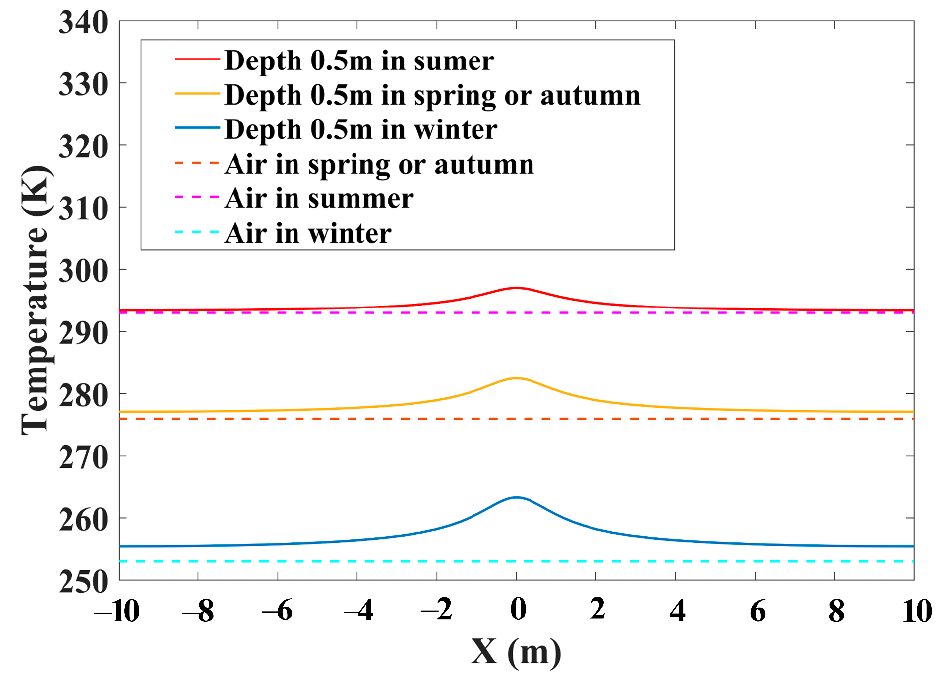
Figure 17. Temperature distribution at 0.5 m depth in different seasons.